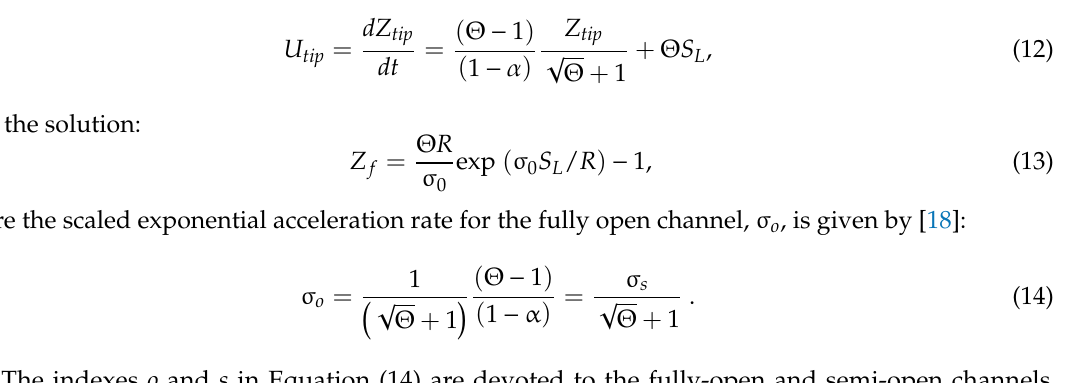
obstructed channels of α = 2/3 for: Θ = 8 with various R / L f = 24, 36, 48 ( a ) and R / L f = 48 with